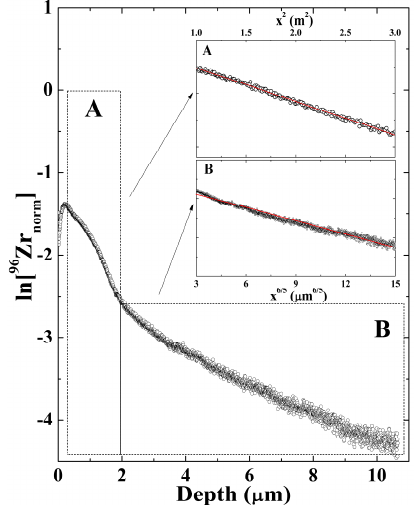
Figure 2. SIMS depth profile for 96 Zr diffusion in polycrystalline SZ annealed at 1450 °C for 4 h. The insets represent the two regions, A and B, modified for the fitting of lattice and grain boundary diffusion coefficients, respectively, together with the fit to the data (red lines).